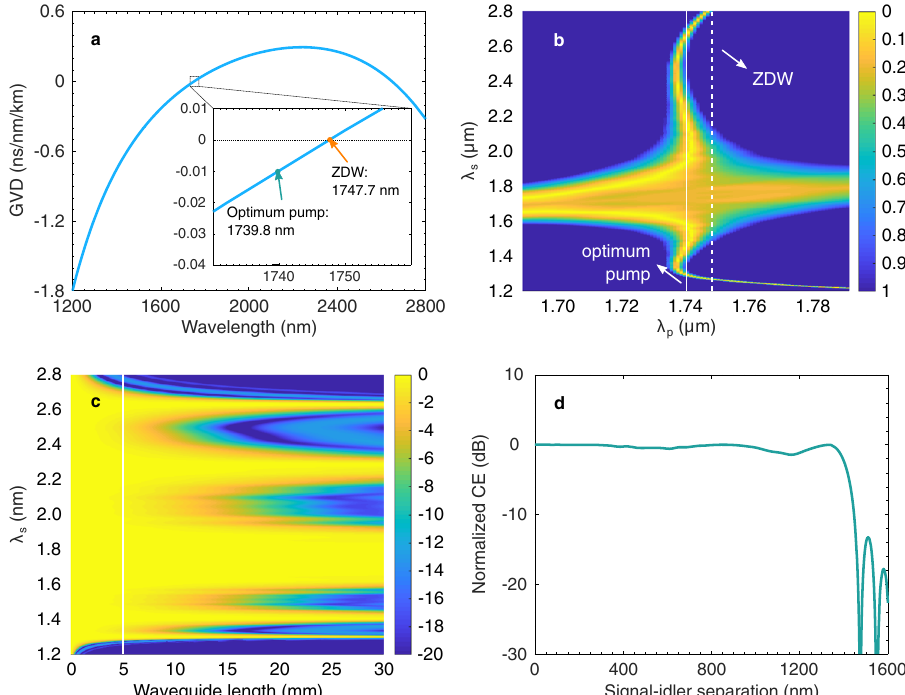
Fig. 2 Simulation results of the AlGaAsOI nanowaveguide. a Group velocity dispersion (GVD) of the AlGaAsOI nanowaveguide. The optimum pump wavelength (1739.8 nm) is shifted from the zero-dispersion wavelength (ZDW) (1747.7nm) to utilize the high-order phase matching, where the fundamental conversion band can be merged with the high-order phase matching band for an extended conversion bandwidth. b Normalised phase (cid:1) (cid:1) (cid:1) (cid:1) as a function of pump and signal wavelengths, with a waveguide length of 5 mm. The white straight solid and dash-dotted lines indicate mismatch Δ β L = π the optimum pump wavelength and the ZDW. c Normalised CW as a function of waveguide length and signal wavelength with the pump at the optimum wavelength. d Normalised conversion ef fi ciency (CE) versus signal-idler separation with a 5-mm-long AlGaAsOI nanowaveguide, when the pump is located at the optimum wavelength. The simulation results show a conversion bandwidth of over 1400